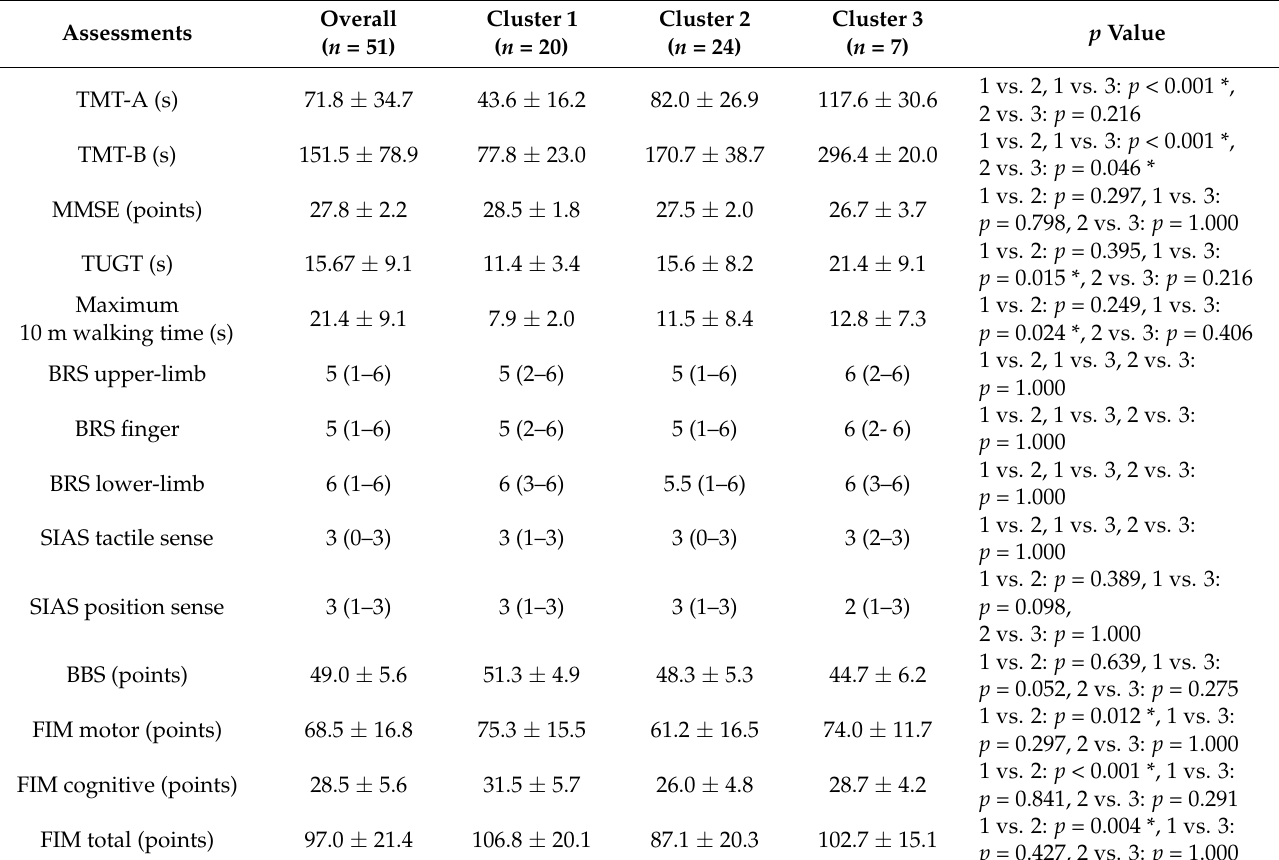
Table 2. Results of executive function and physical function in all participants and the three